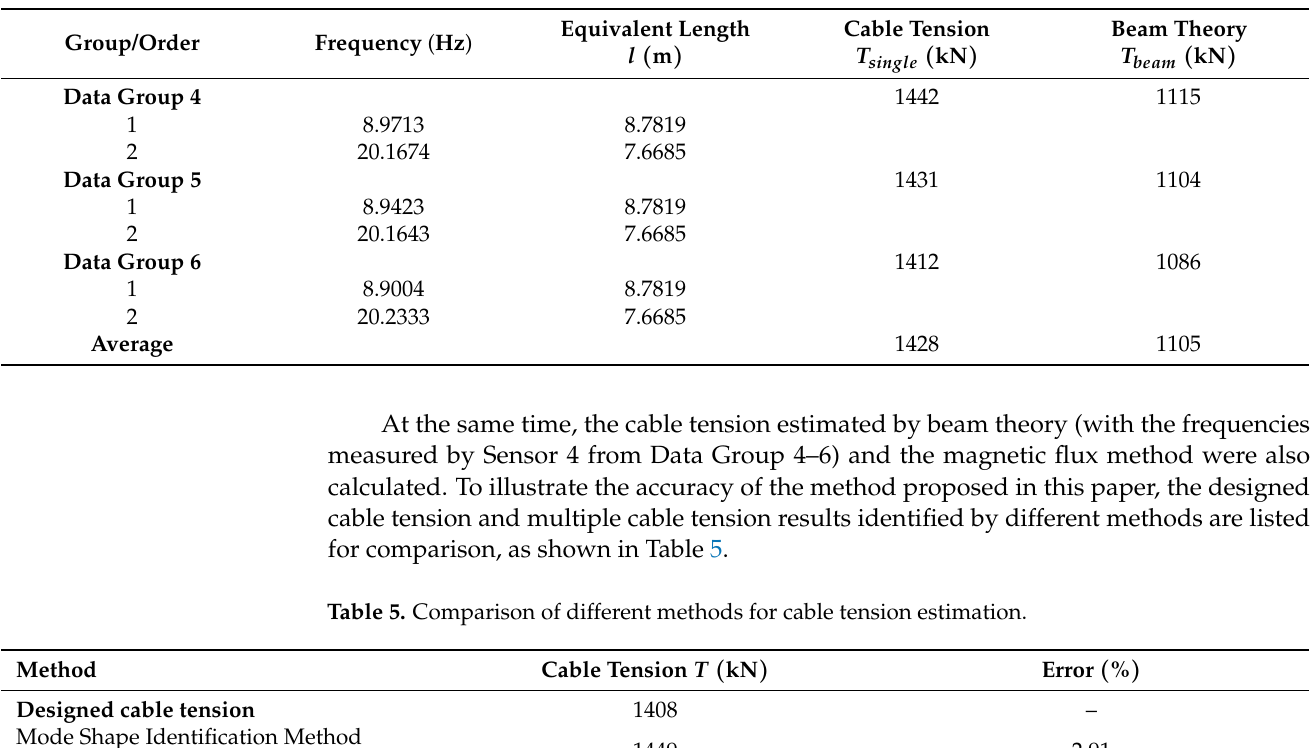
Table 4. Cable tension estimation results based on mode shape measurement (Data Group 4–6).